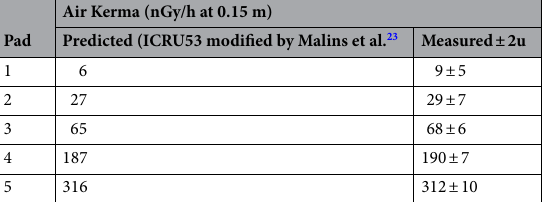
Air Kerma (nGy/h at 0.15 Pad